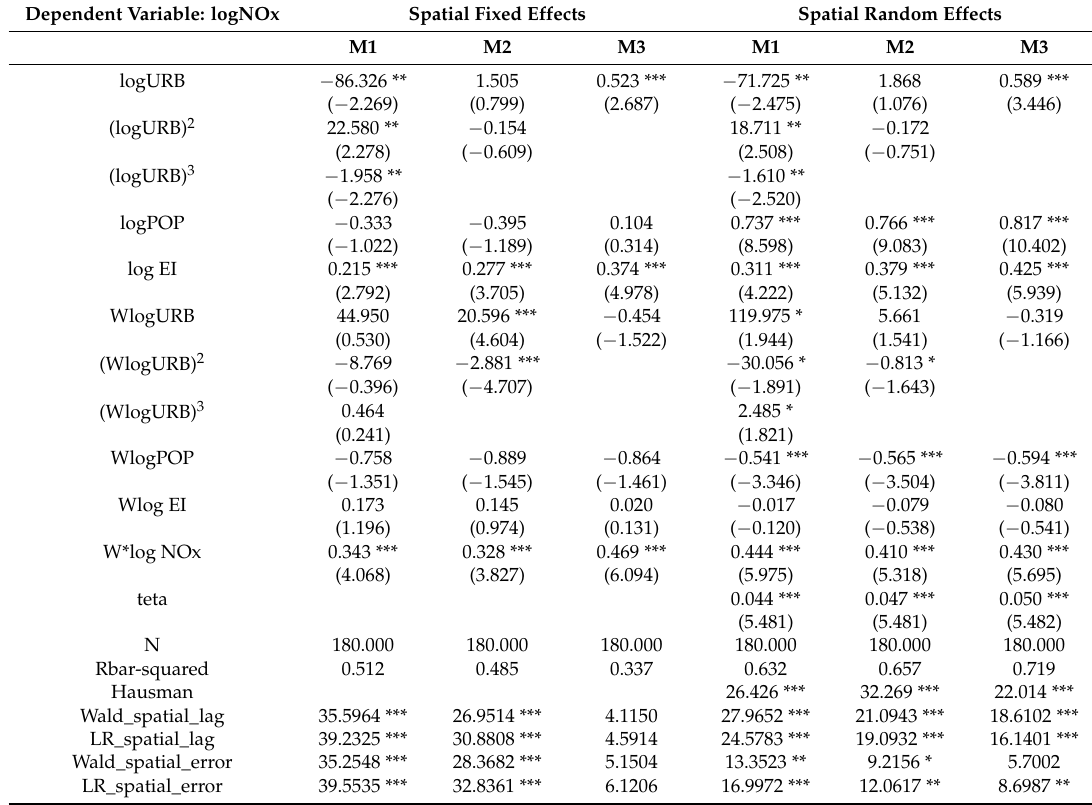
Table 5. Parameter estimates of the spatial panel model (urbanization as the indicator of